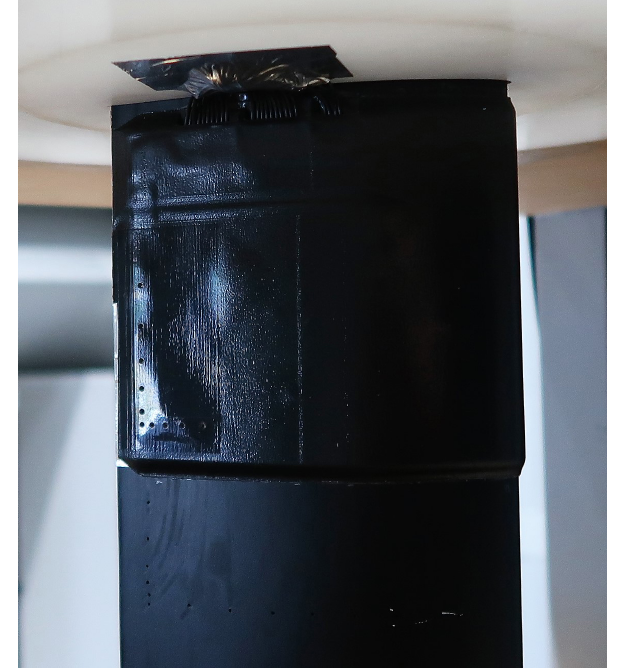
Figure 1. Photo of the 10 microphones installed on a NACA63418 profile in the anechoic wind tunnel at Ecole Centrale de Lyon. The chord of the airfoil is 125mm.